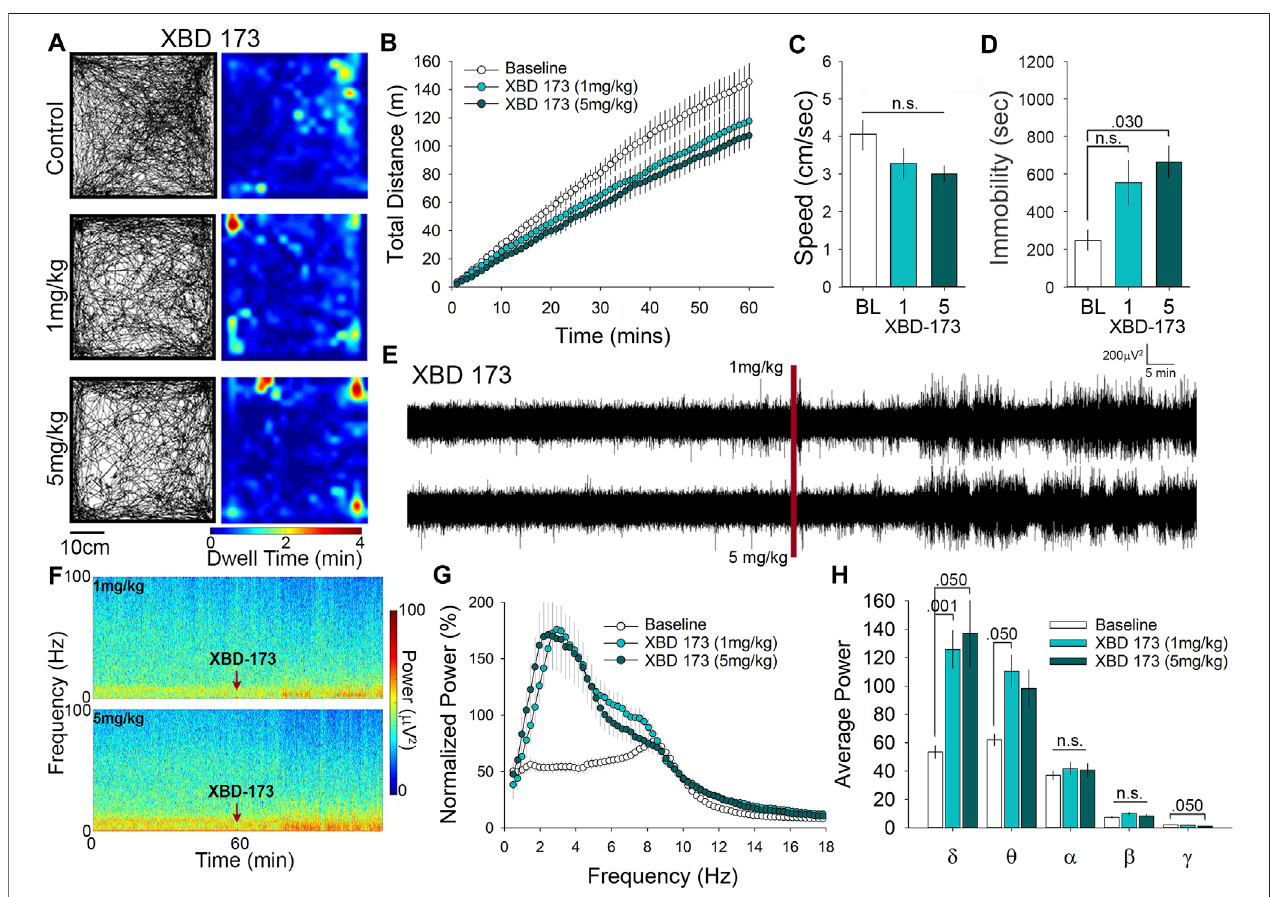
FIGURE4 | XBD-173 reduces locomotion in theopen fi eldat thehigher dose of5 mg/kg yet signi fi cantly alters both δ and θ power at 1 mg/kg. (A) Representative paths and heatmaps of animal position throughout the open fi eld test. XBD-173 did not result in a signi fi cant change in cumulative distance traveled (B) or the average speed of travel (C) in the open fi eld at either 1 or 5 mg/kg. (D) Treatment with 5 mg/kg XBD-173 did signi fi cantly increase the time immobile. (E) Raw trances and spectrograms (F) ofthe2-hrecordingperiod,withtheredlineandarrowsindicatingtimeofi.pinjection. (G) cFFTcomparing1-hbaselinerecordingstorecordings following i. p. injection of 1 mg/kg and 5 mg/kg XBD-173. (H) Spectral analysis of speci fi c frequency bands in the EEG reveals increases in δ and θ power at 1 mg/kg XBD-173, while at 5 mg/kg δ and γ power are signi fi cantly altered compared to